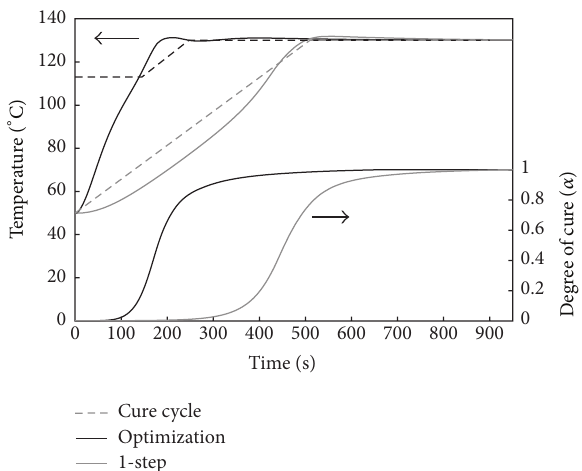
Figure 15: Comparison of cure profile between optimized and one- step curing